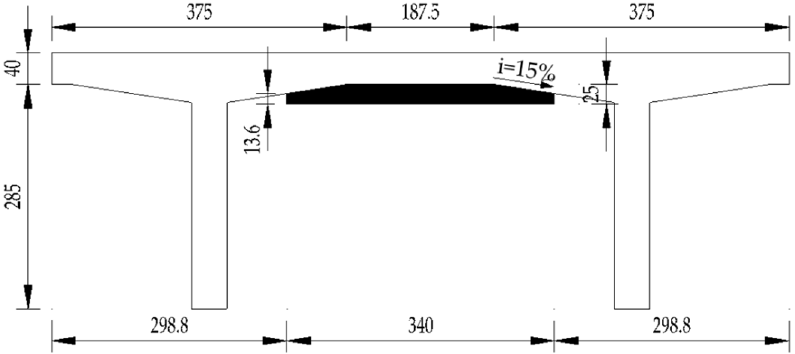
Figure 4. The cross-section of the polyurethane concrete reinforcement layer (unit: mm).